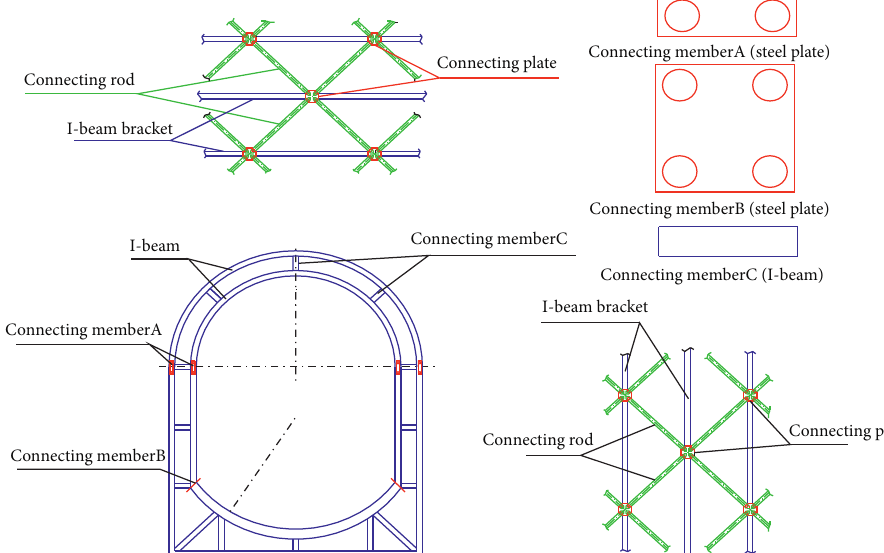
Figure 13: Schematic diagram of the flexible truss structure.